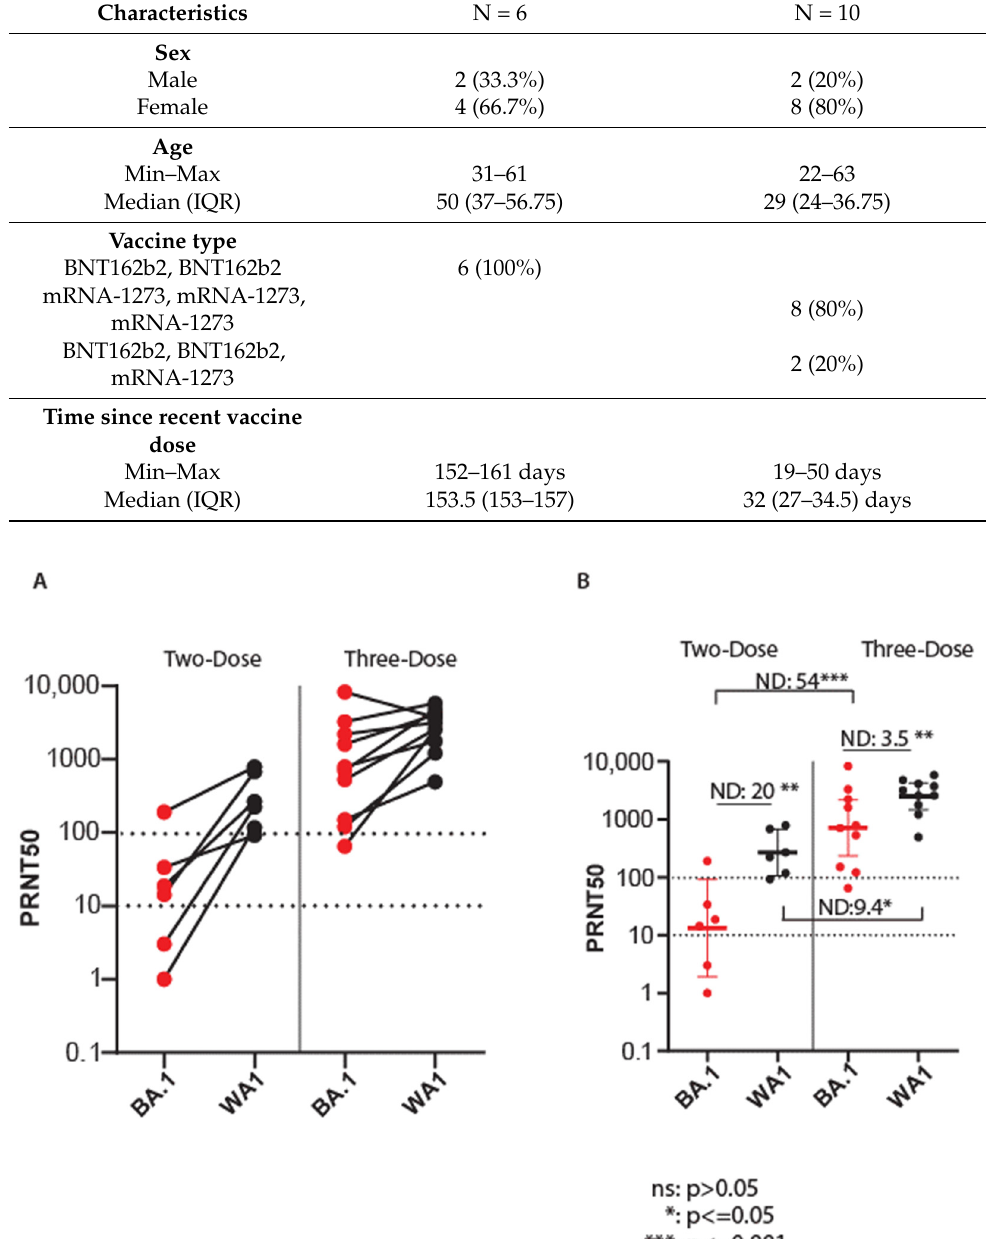
Table 3. Characteristics of donors who received a two-dose regimen or three-dose. Two-Dose Three-Dose